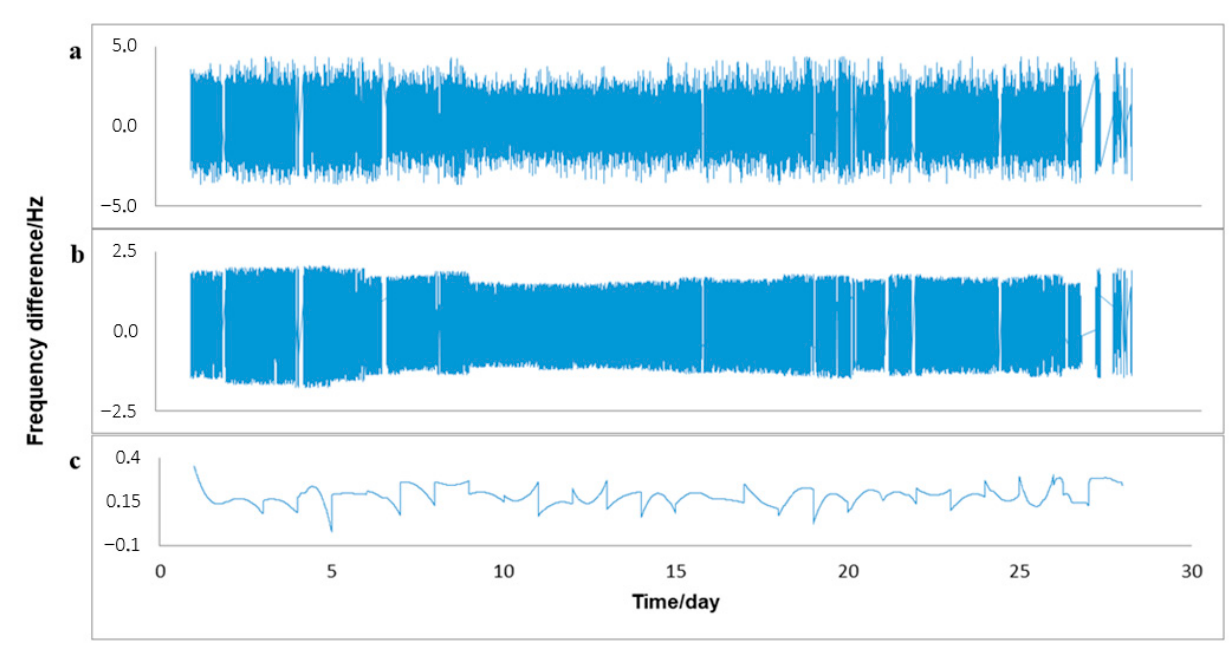
Figure 3. The frequency difference measurement between two optical clocks located at the same site. ( a ) Original data; ( b ) residual data after data processing, namely the gross errors removed; and ( c ) residual data after EEMD.